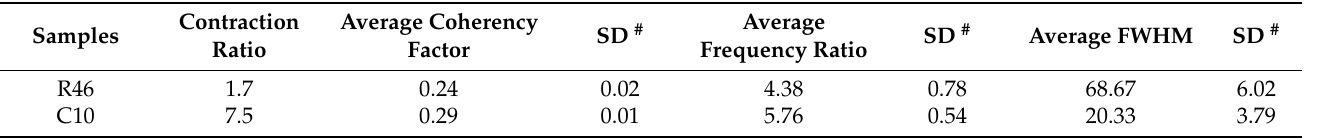
width at half maximum (FWHM) of the fibre orientation distribution profiles. (FWHM) of the fibre orientation distribution